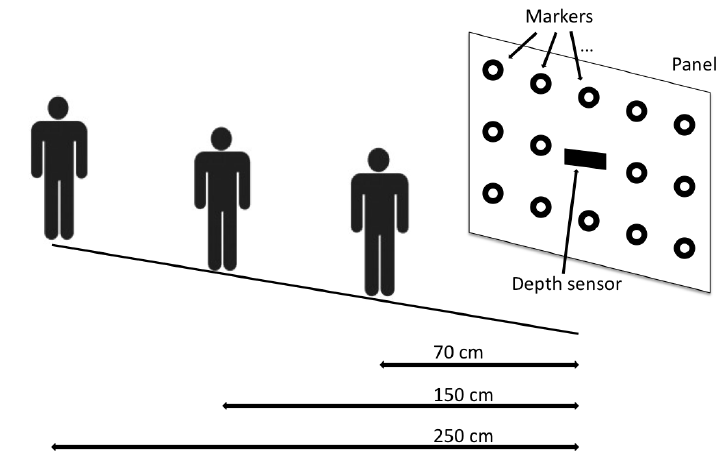
Figure 7. The different users positions for the experimental